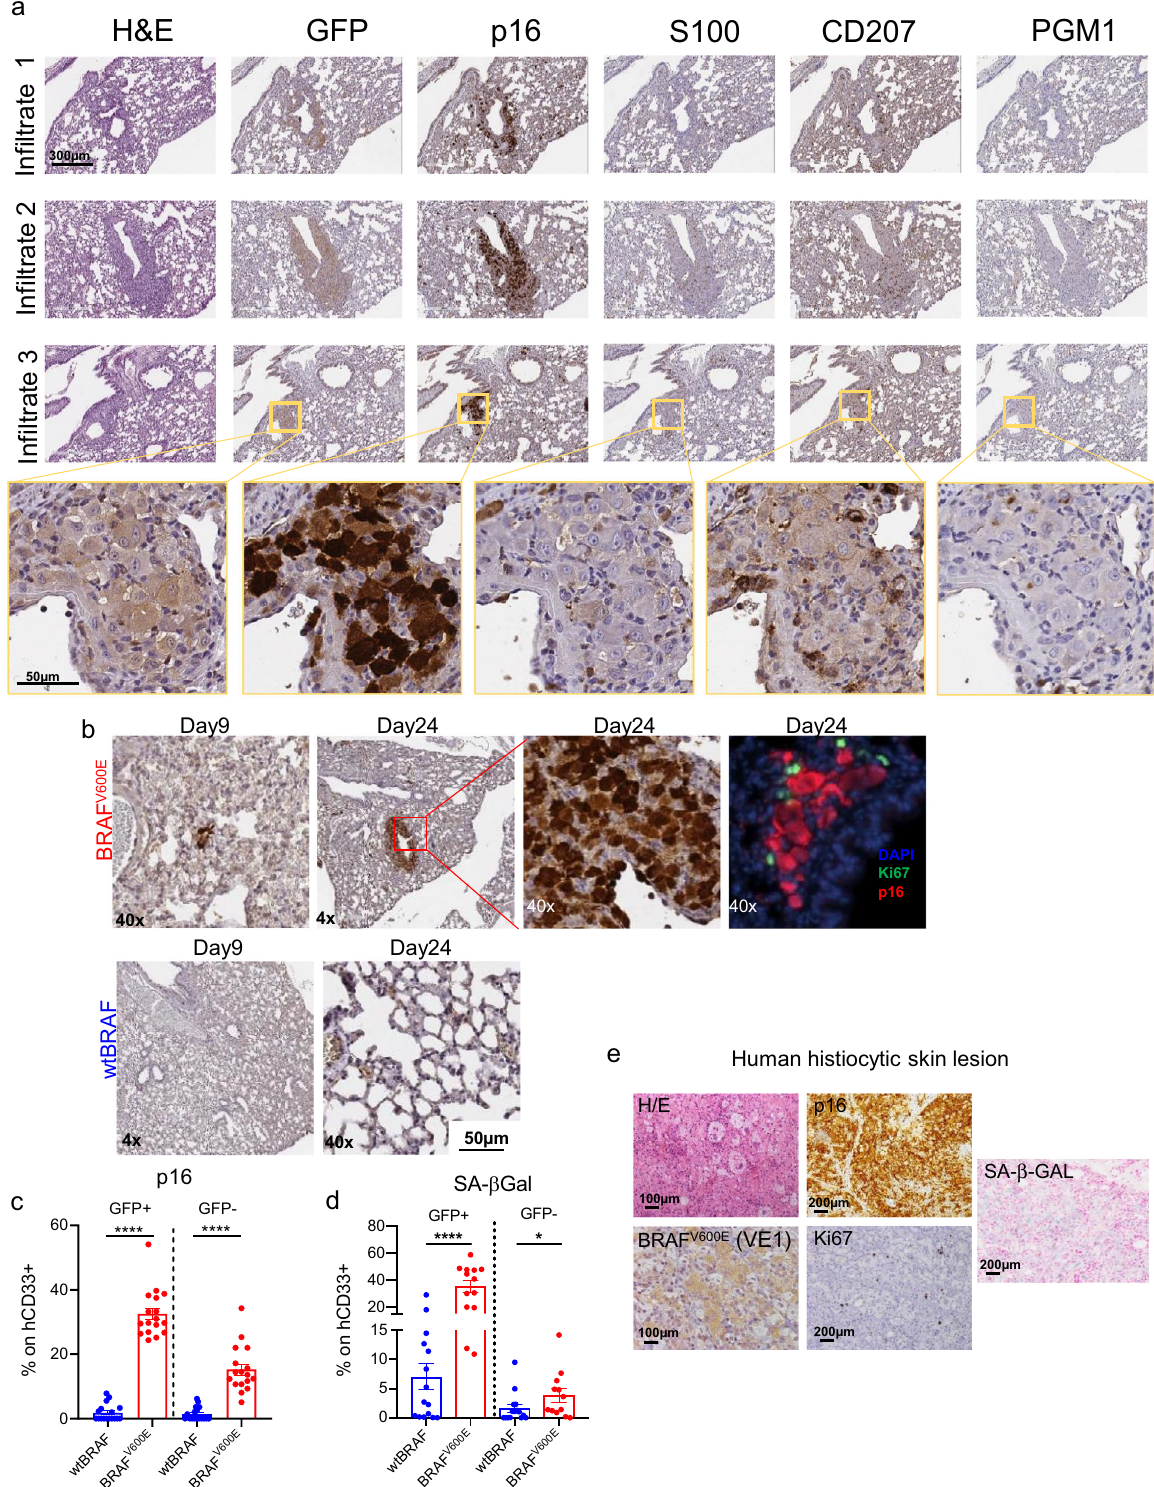
Cells exposed to CM from BRAF V600E -expressing HSPCs cells showed a signi fi cant reduction in their proliferation rate overtime and clonogenic potential (Fig. 7d, e), accompanied by a sig- ni fi cant increase in the gene expression levels of cell cycle inhi- bitors, p16 and p21 , and SASP cytokines, such as I L1 α , IL1 β , TNF α , IL8, and MCP1 , when compared to HSPCs exposed to wtBRAF , derived CM (Supplementary Fig. 8b). To identify